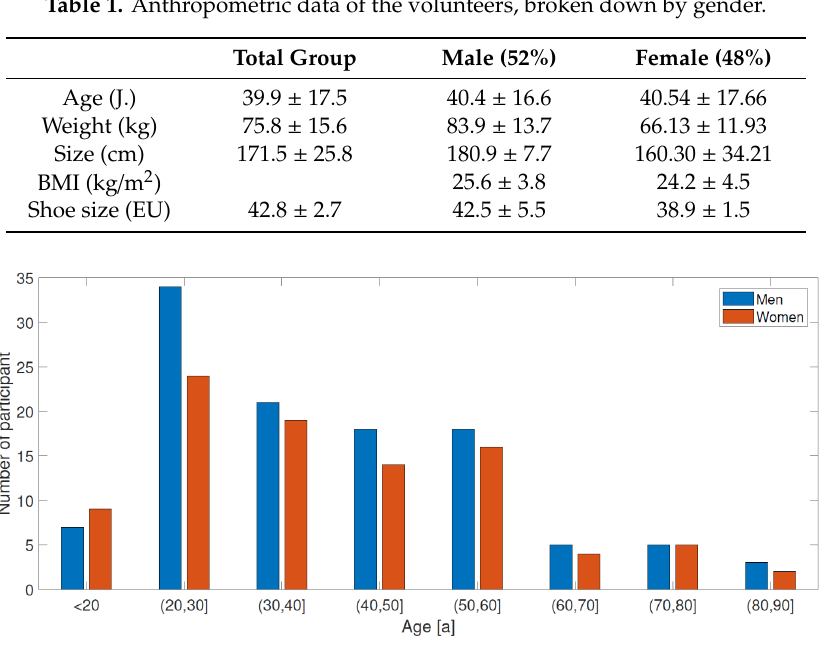
Figure 3. Age distribution of the test persons.